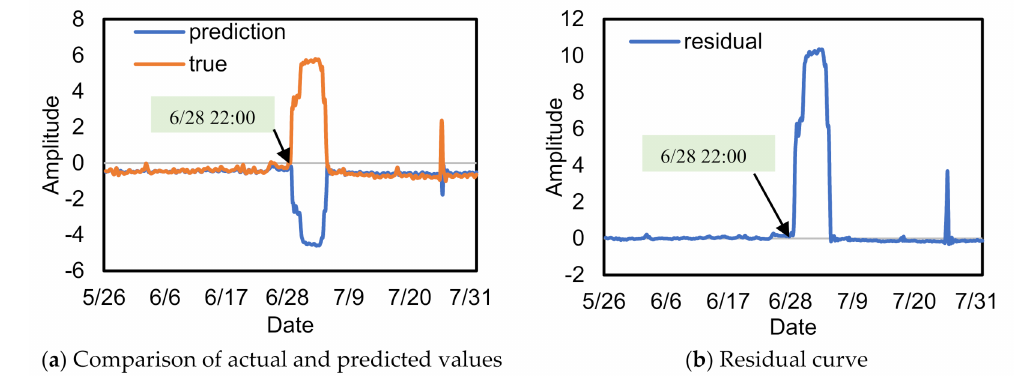
Figure 8. LSTM prediction results.